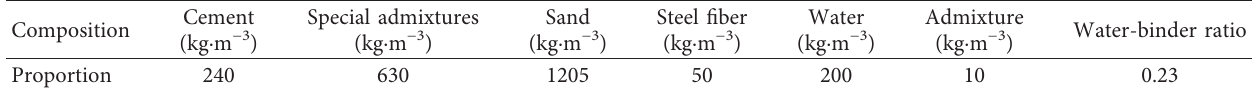
Table 2: Mixing proportions of